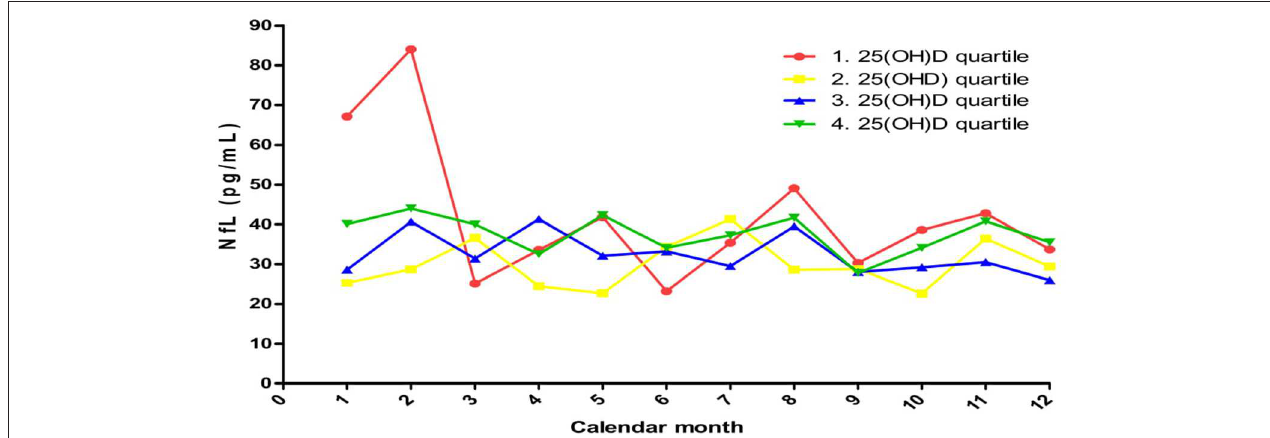
FIGURE 5 | Mean serum NfL concentrations during the year when stratified by 25(OH)D quartiles based on whole study mean values 1. quartile: 30.9–55.6 nmol/L; 2. quartile: 56.1–65.8 nmol/L; 3. quartile: 66.2–78.3 nmol/L;4. quartile: 78.4–128.6